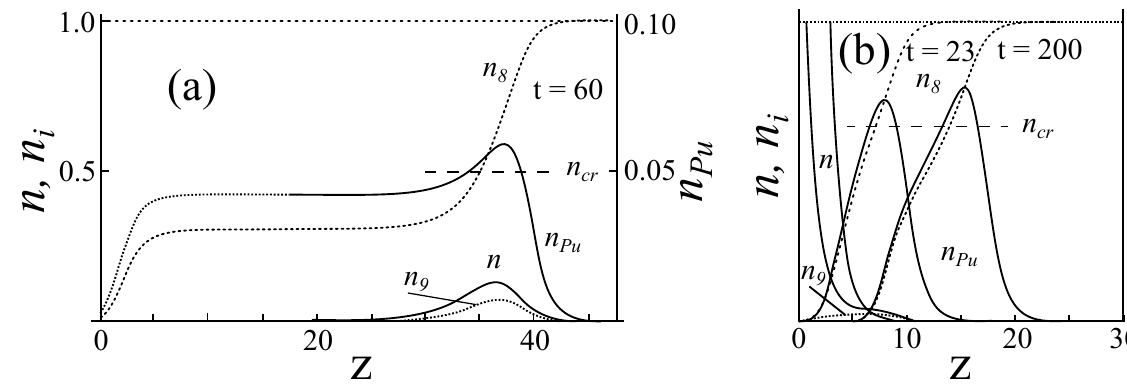
( z ) above the n line is the reactor core; the scales Pu cr